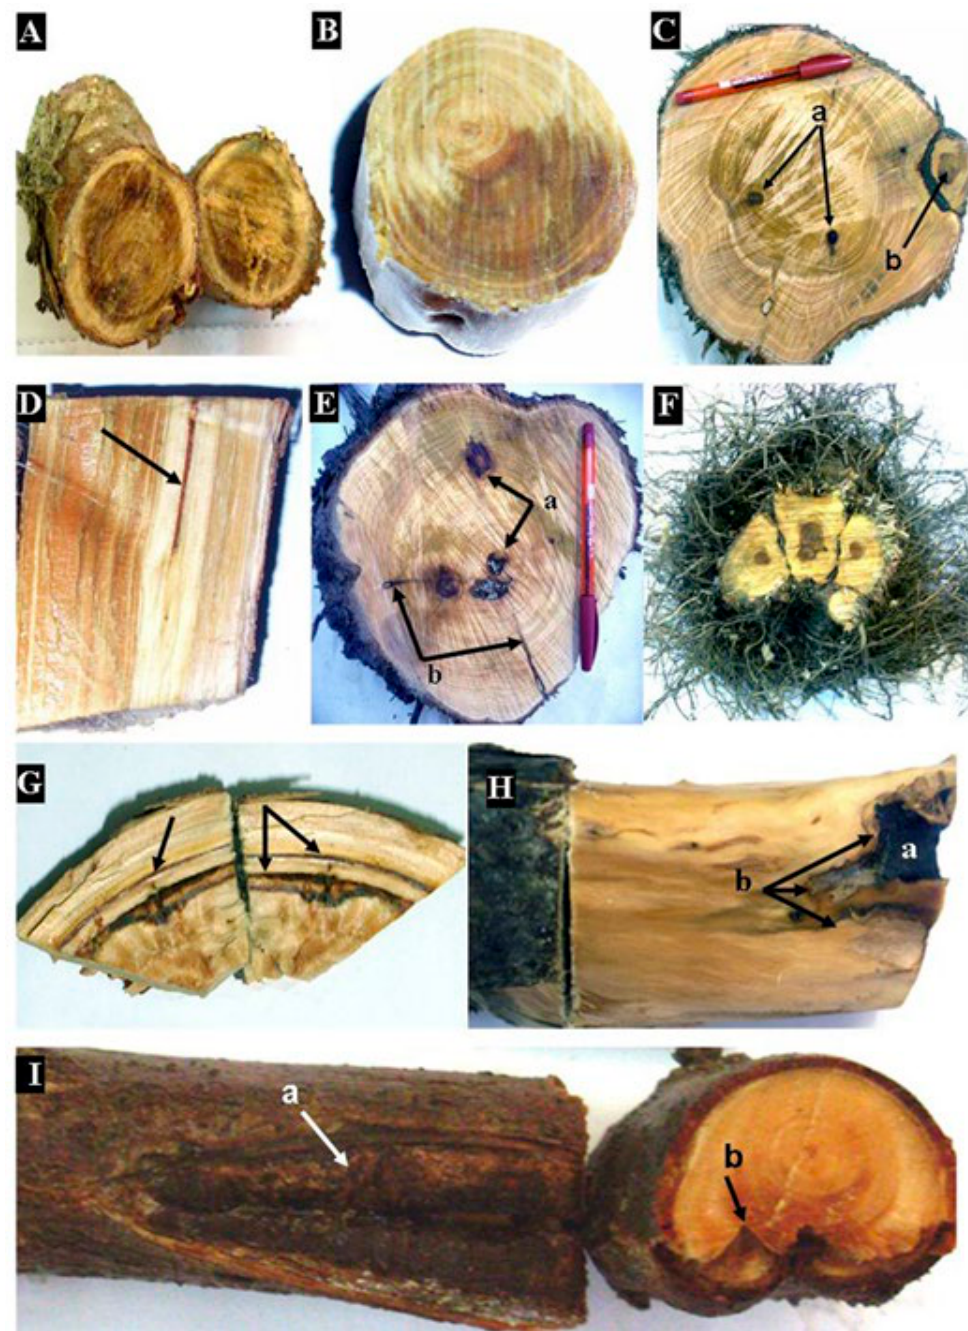
Figure 1. Symptoms associated with trunk disease on cypress trees. A, central wood necrosis. B, watery necrosis, C, co- occurrence of black spots (a) and central necrosis on a lateral branch (b). D, vascular discoloration as a brown line in longi - tudinal section , indicated by arrow. E, co-occurrence of black internal necrosis (a) and black wood streaking (b). F, internal wood necrosis at the crown of affected cypress trees. G, brown to black wood streaking in cross section. H, canker (a) and dark brown wood discolorations around the affected tissues of a canker (b). I, a canker in longitudinal (a) and cross section with wedge-shaped wood discoloration